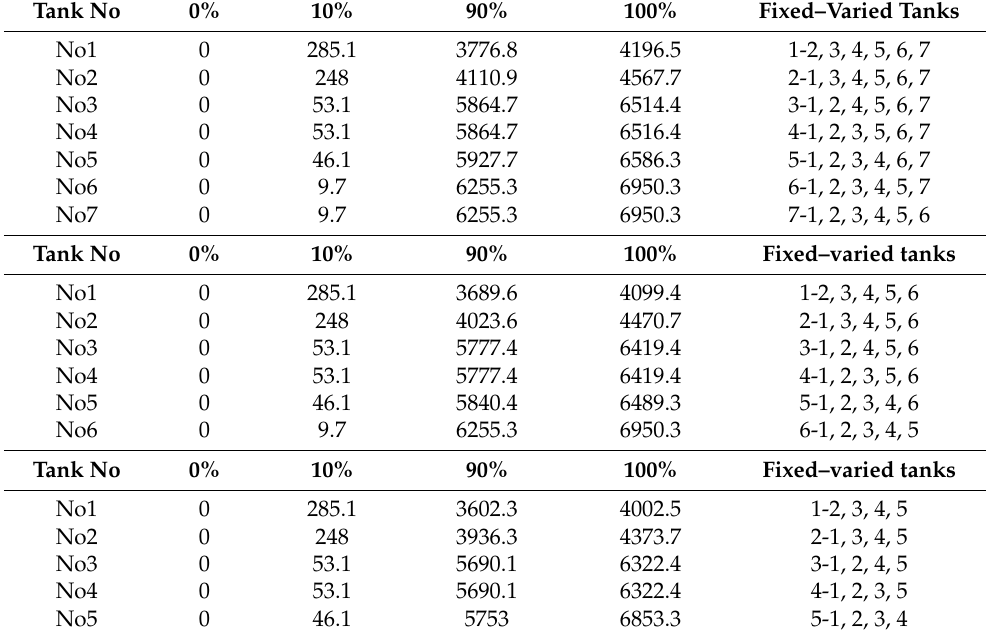
Table 5. The interval of the tanks and tank available spaces.